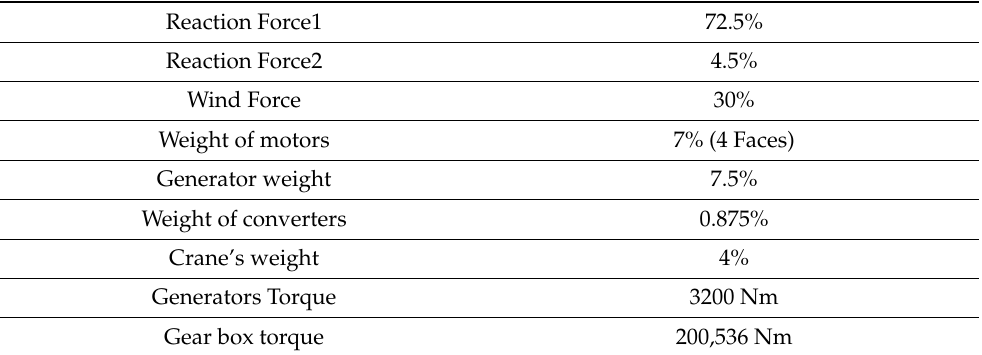
Table 1. Applied boundary conditions for a full load [30]. (Forces were scaled as percentage of the total weight of nacelle).